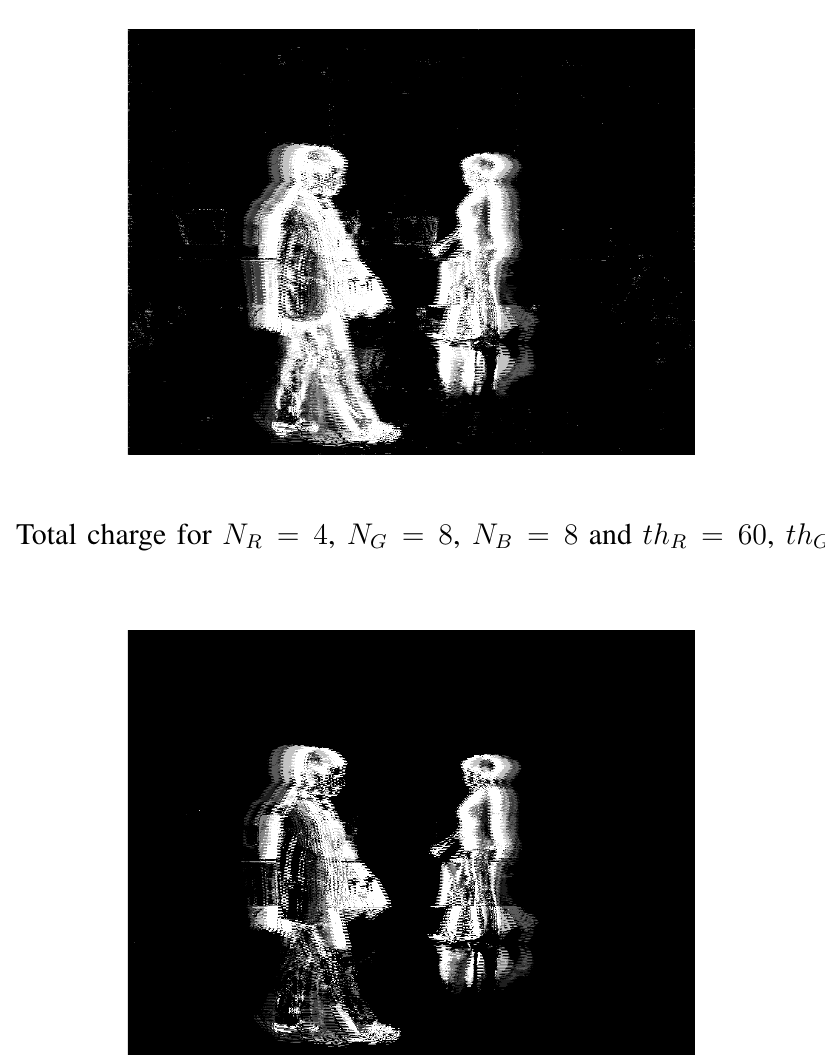
Figure 11. Total charge for N th = 16 . B